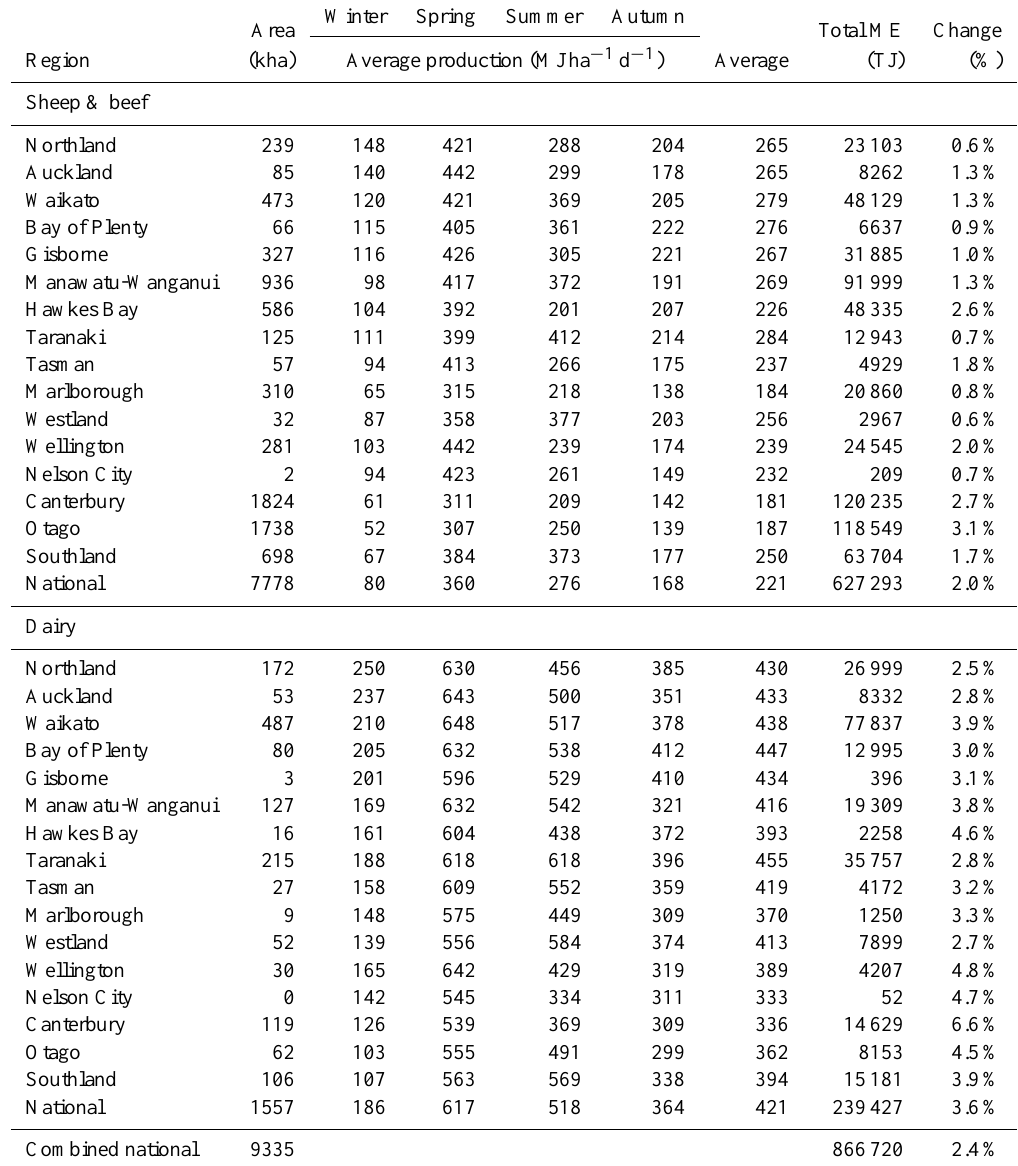
Table B5. Climate change 2050 (GIEH